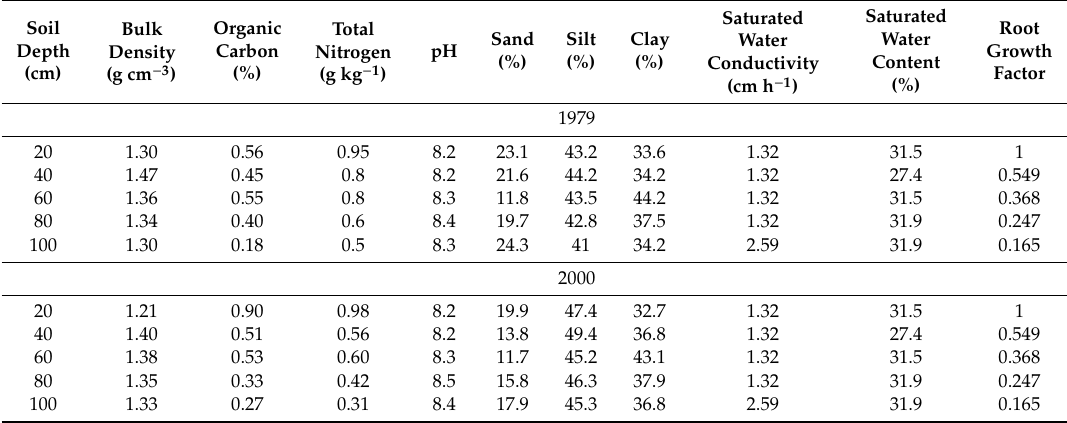
Table 1. The soil parameters required for the decision support system for agrotechnology transfer (DSSAT) model in 1979 and